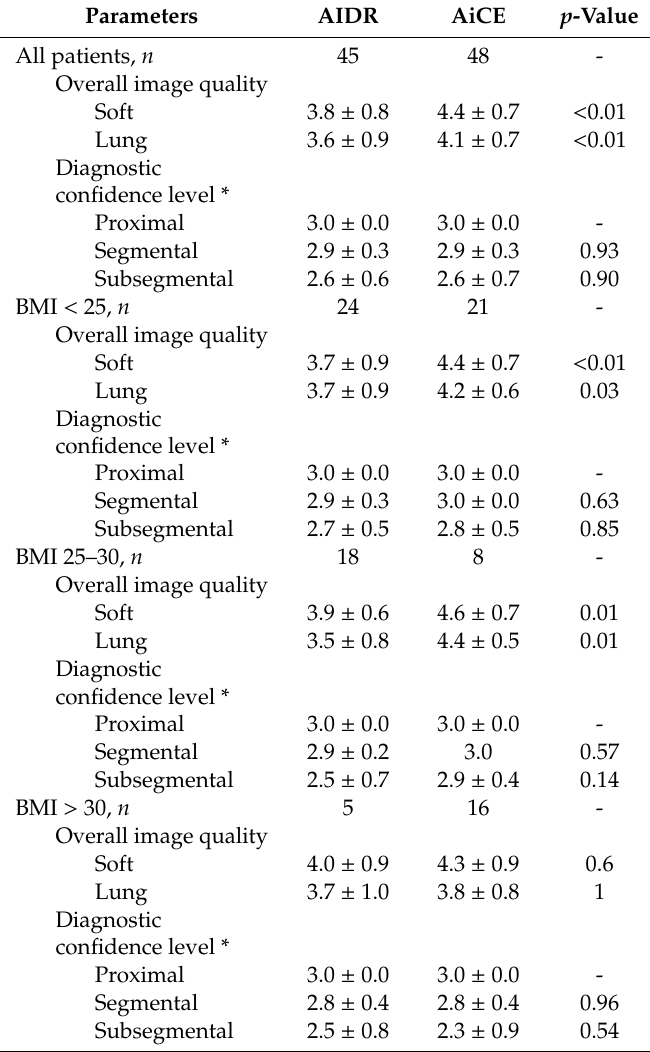
Table 3. Qualitative analysis of CT image quality for hybrid-IR (AIDR 3D) and DLR (AiCE). Parameters AIDR AiCE p